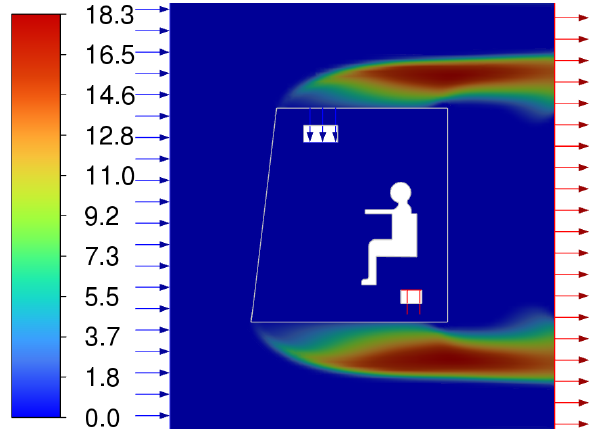
Figure 14. Values of turbulent kinetic energy k , m 2 /s 2 . To study the influence of velocities, the values of velocities along the walls in the near-wall layer were additionally calculated for distances of one cell, which corresponds to 6 mm. In the boundary value problem in Equation (2), all velocities on the walls were equal to zero, but they increased rather quickly when moving away from the walls. As an example, Figure 15 shows the velocity 𝑢 (cid:3052) along the horizontal axis at a distance of three outer layers and three inner layers of the grid. The points correspond to the values in the nodes. It can be seen that, at a distance of 6 mm, the speed increased and stabilized. The speed values are shown in Figures 16–18. Here, In denotes the speed inside the cabin, while Out denotes the speed outside the cabin.